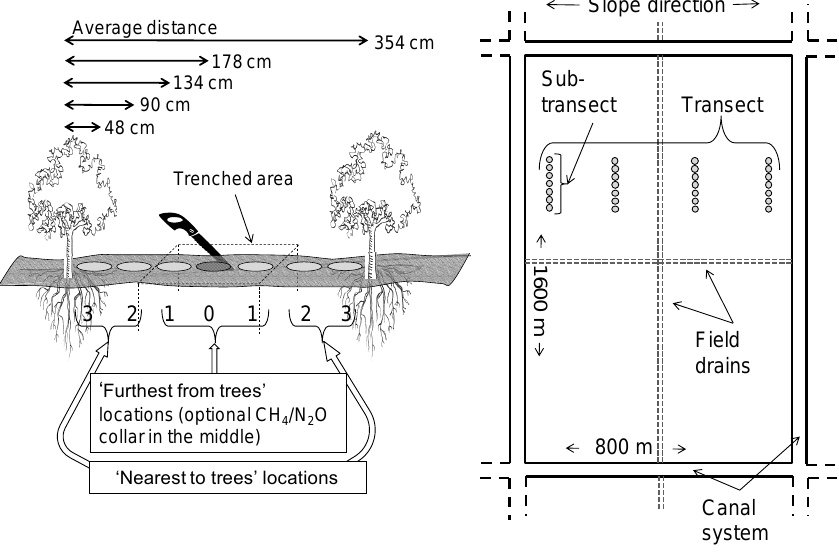
Fig. 1. Outline of CO 2 emission monitoring location arrangement at a sub-transect, and of a transect in a tree growing unit. Table 2. Tree stand age characteristics (months) and average water table characteristics (m from the peat surface) at the CO 2 monitoring transects over the two year monitoring period. Tree stand age (months) Water table depth